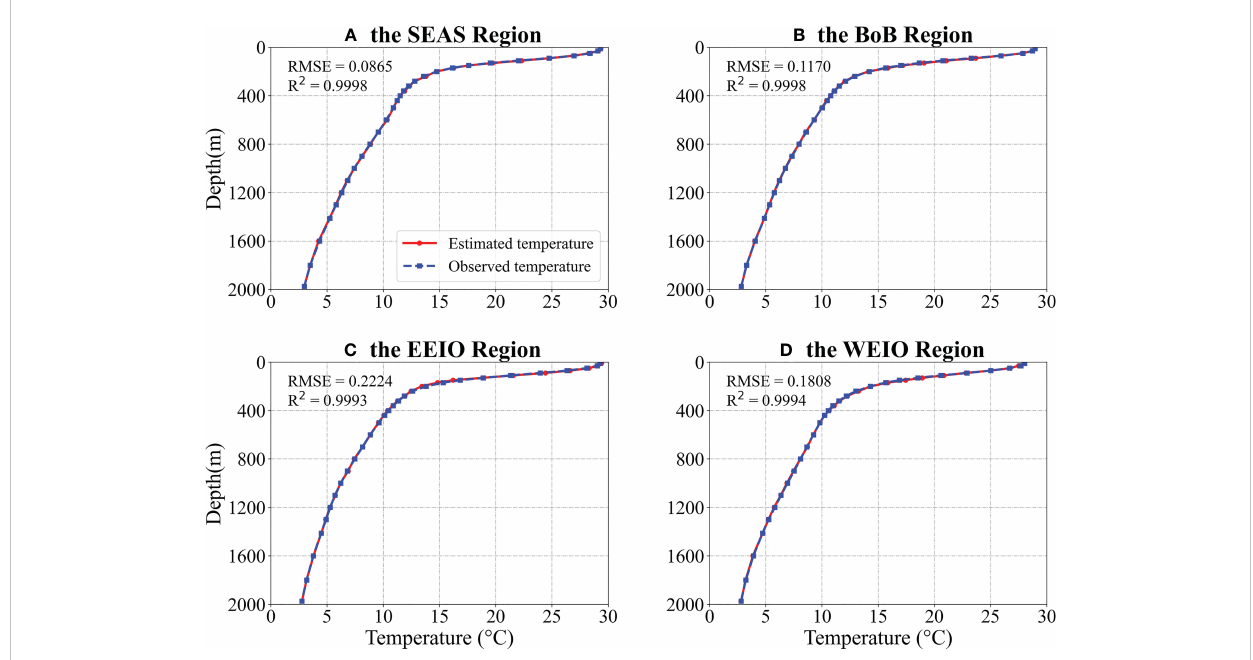
FIGURE 8 Comparison of area-averaged temperature pro fi les [ (A – D) Boxes A-D ] at different depths by the CBAM-CNN model estimated (red dotted line) and Argo observed (blue star